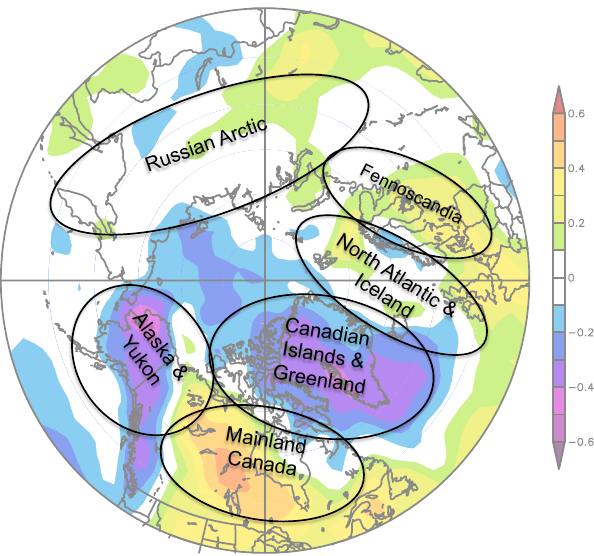
Figure 1. Six Arctic regions represented in this database. Map colours indicate strength of correlation between summer (JJA) surface air temperature and the Arctic Oscillation from 1950 to 2011 within the NCEP/NCAR Reanalysis data (output from NOAA/ESRL Physical Sciences